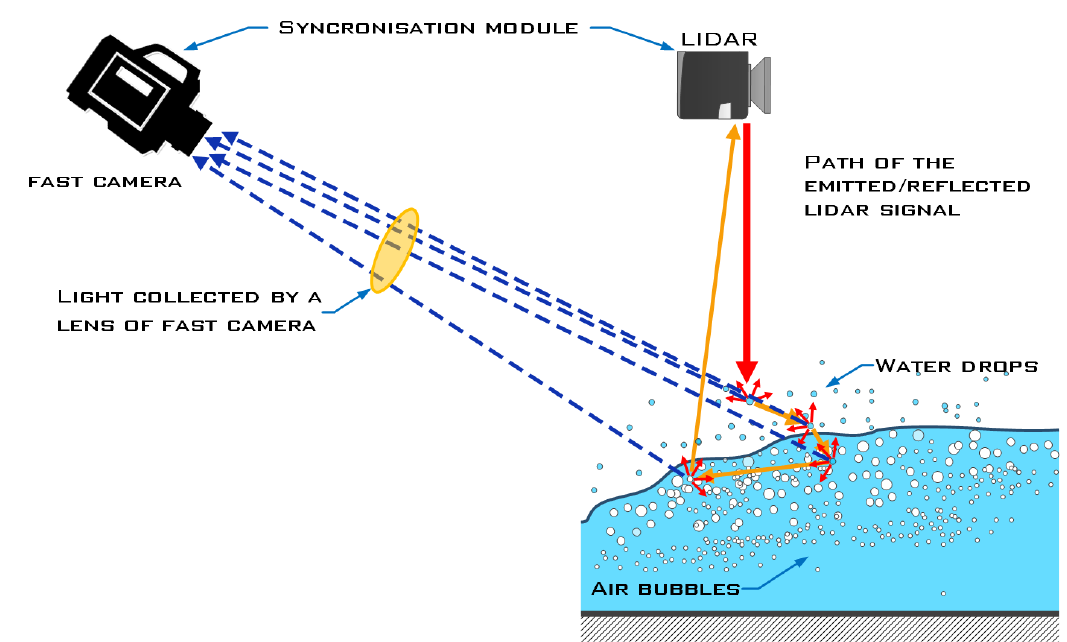
Figure 4. Specular reflections of the laser scanner beam on an aerated water surface [11].